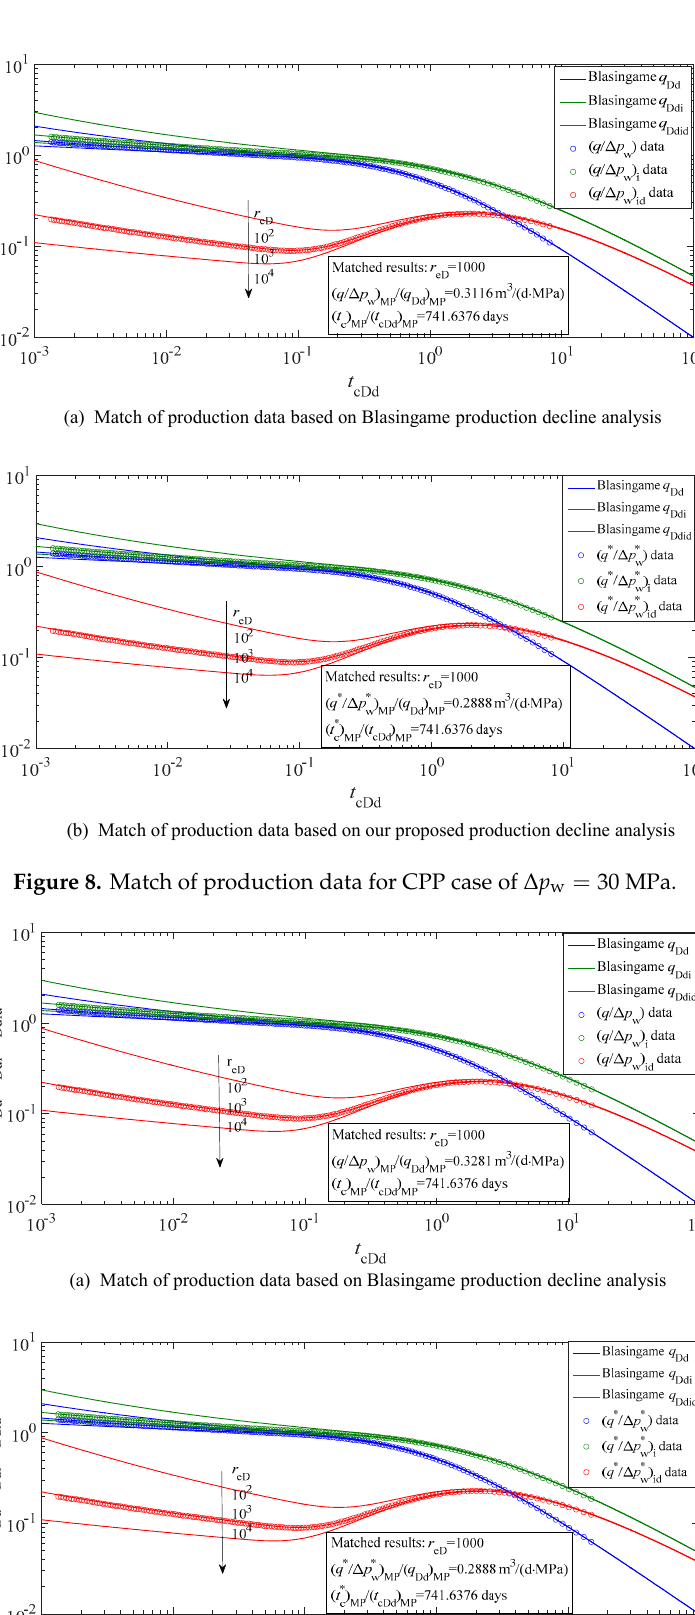
Figure 10. Match of production data for CPP case of